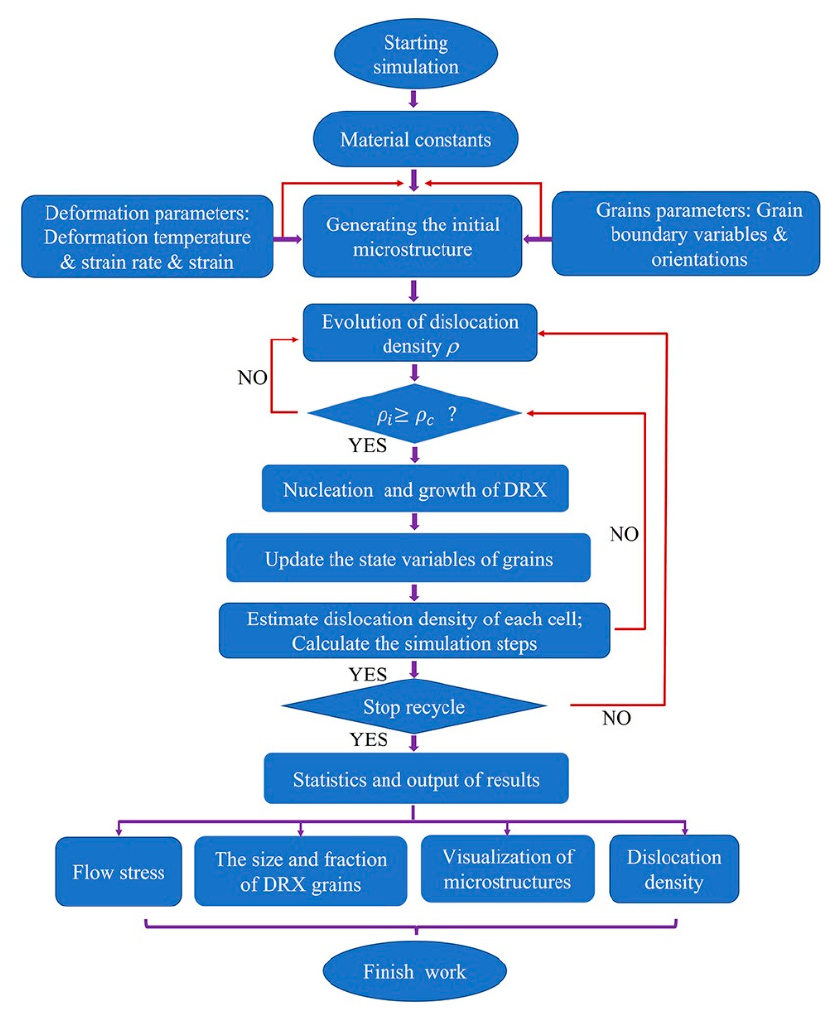
Figure 5. Flowchart of DRX simulation via CA